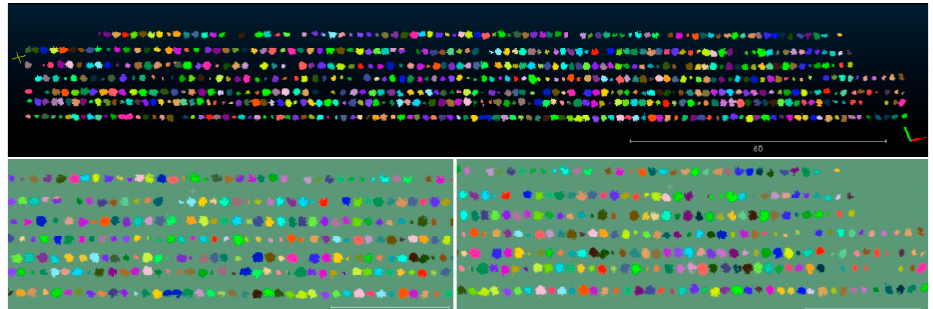
Figure 8. Point cloud segmentation effect: the upper part of Figure 8 is the overall segmentation view, and the lower part is the partially enlarged view.